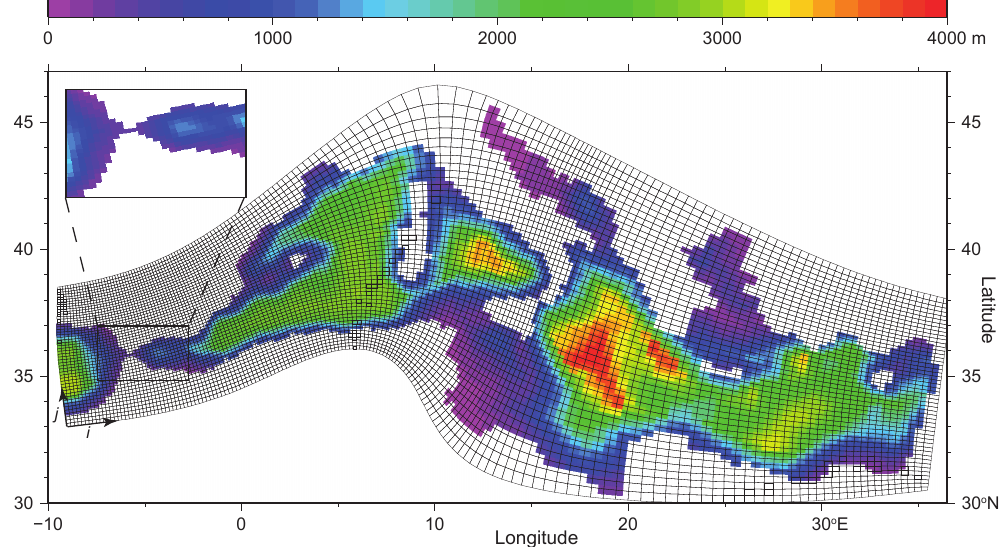
Figure 1. Model grid and bathymetry. Curvilinear grid coordinates i and j increase along curved lines towards, roughly, the east and north. The small inset shows the geometry of the Strait of Gibraltar in more